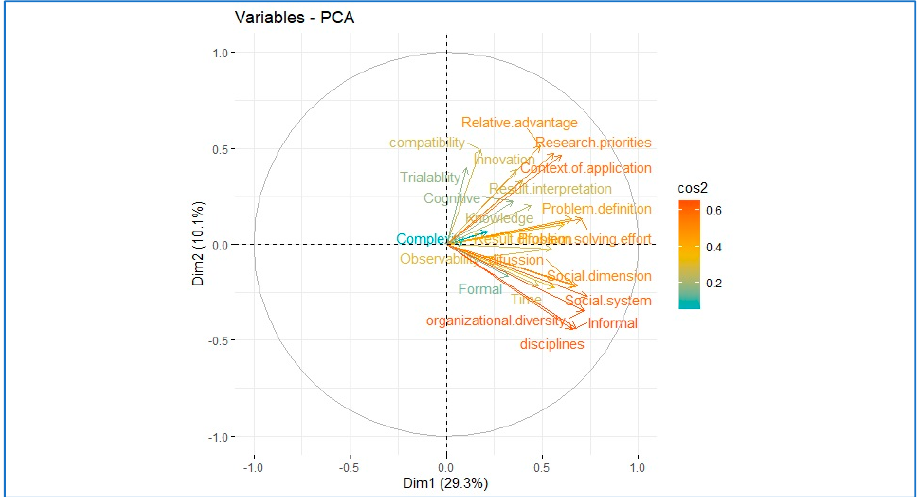
Figure 2. The quality of representation (cos2) plot for the first two dimensions.